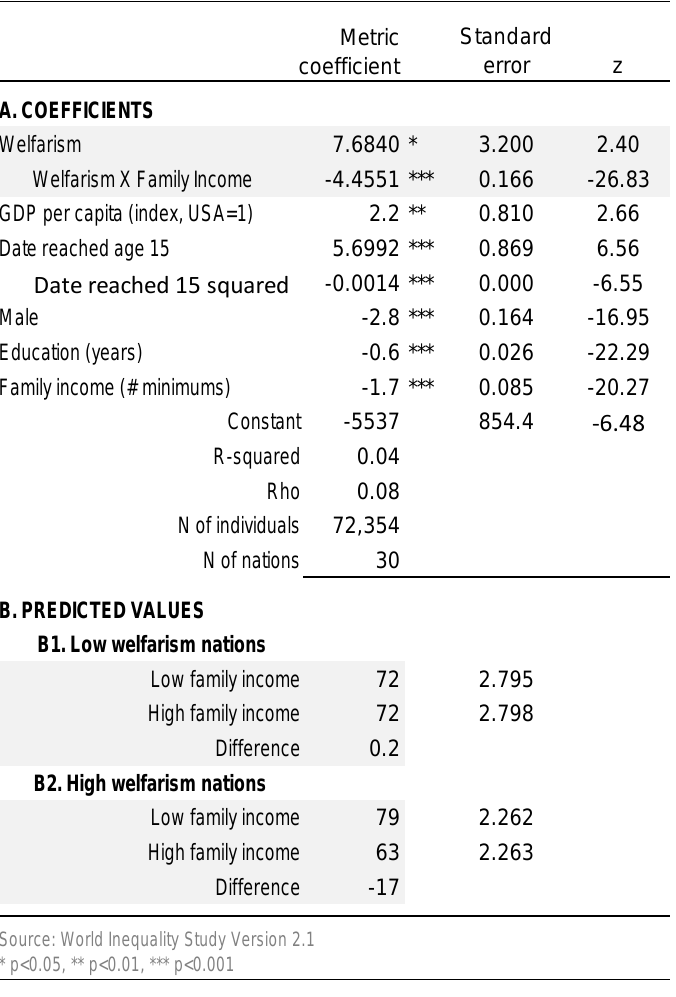
Figure 16. Welfarism and attitudes toward income redistribution. Multilevel regression with a cross-level interaction between welfarism and income, estimated by GLS. Metric coefficients (Panel A) and predicted values (Panel B). Individual level data for 30 nations, 1987–2009. Sensitivity tests using alternative welfarism definitions show the same pattern (Appendix E).